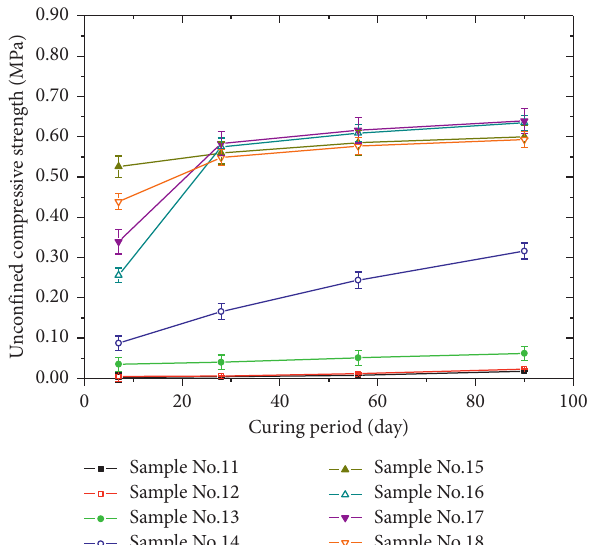
Figure 11: Influence of curing period on UCS of samples stabilised with NaOH and GGBS.